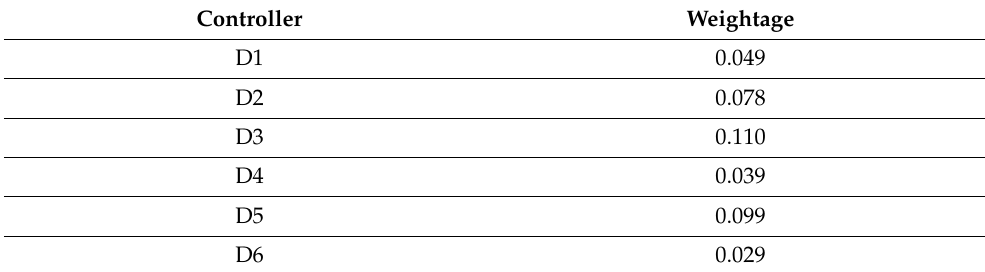
Table 5. Ranking of the controller for SD-IOT using